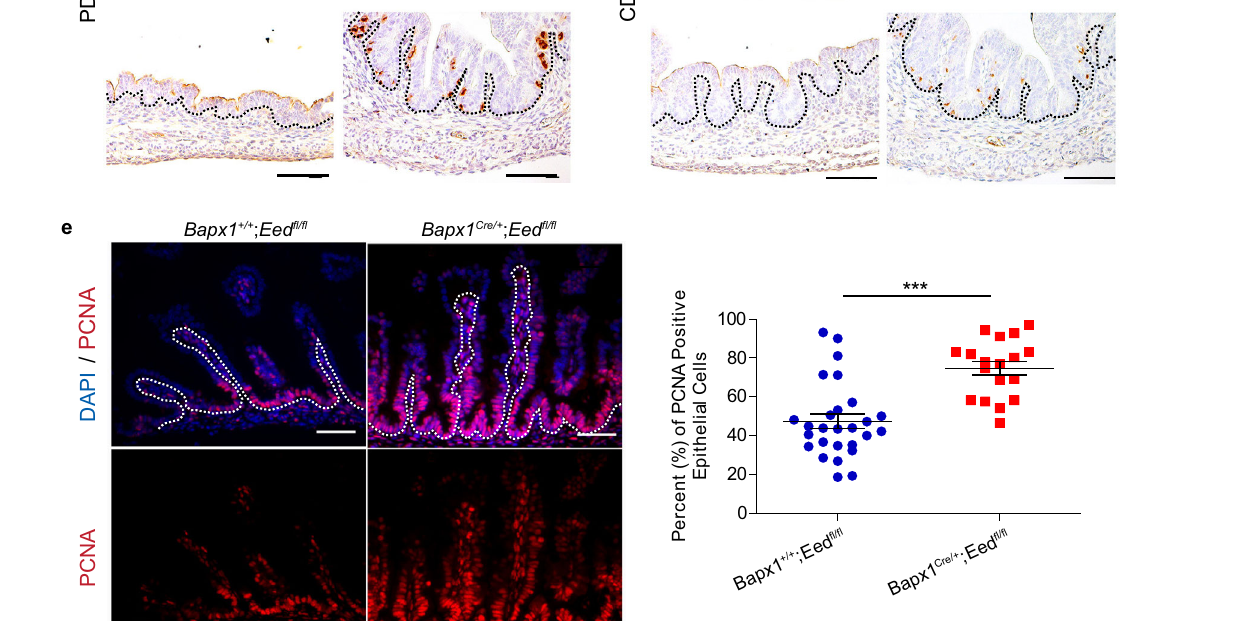
immuno fl uorescence shows epithelial proliferation in E17.5 mice. Average per- centage of proliferating intestinal epithelial cells per villus across n =8 Bapx1 +/+ ; Eed fl / fl mice and n =5 Bapx1 Cre/+ ; Eed fl / fl mice (duodenal tissues, ±SEM, *** P <0.001 by Student ’ s t -test, two-tailed). Source data are provided as a source data fi le. Scale barsrepresent50 µ m.Dashedlinesseparatetheepithelium(Epi)andmesenchymal cells